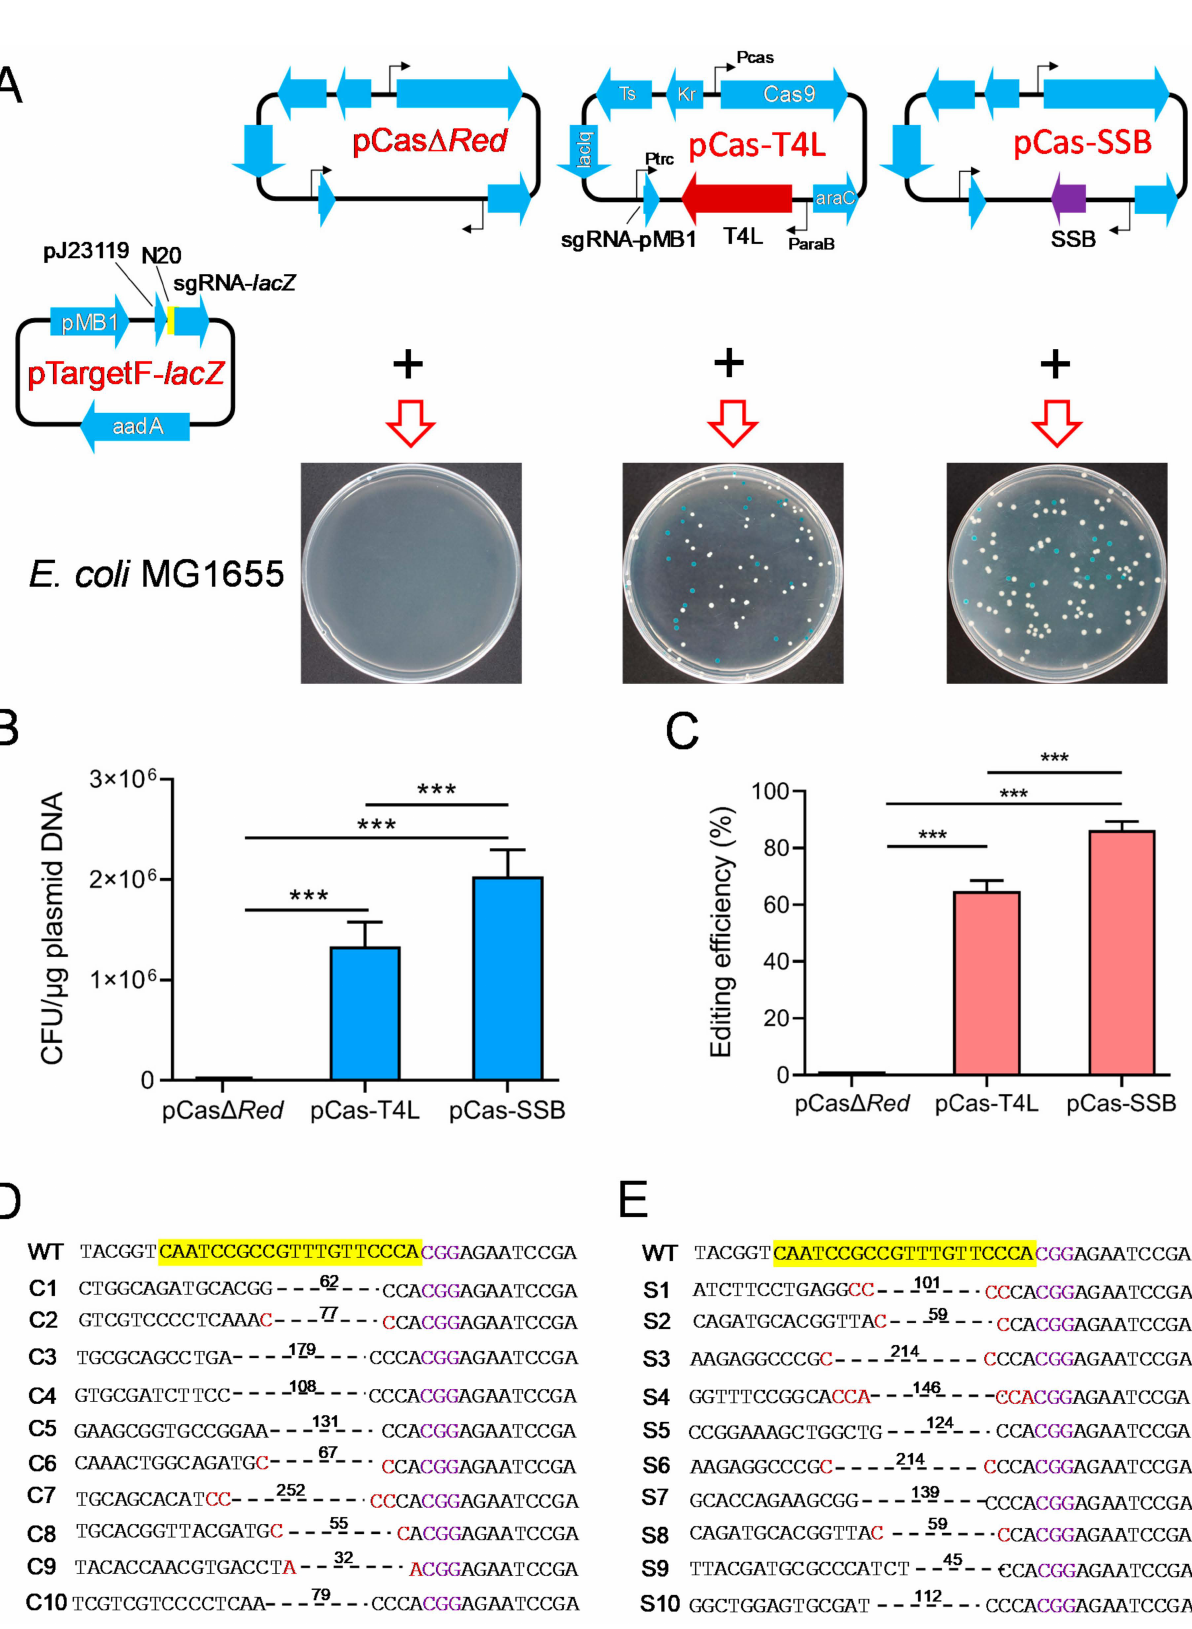
Figure 2. Effects of SSB- and T4 DNA ligase-mediated NHR repair of DSBs on CRISPR-Cas9 gene editing to delete the E. coli lacZ gene. ( A ) Illustration of Cas9 and sgRNA expression plasmids and their transformation into E. coli MG1655. pCas-T4L is derived from pCas by replacing λ -Red recombinases with phage T4 DNA ligase. ( B ) The transformation rate of the CRISPR-Cas9